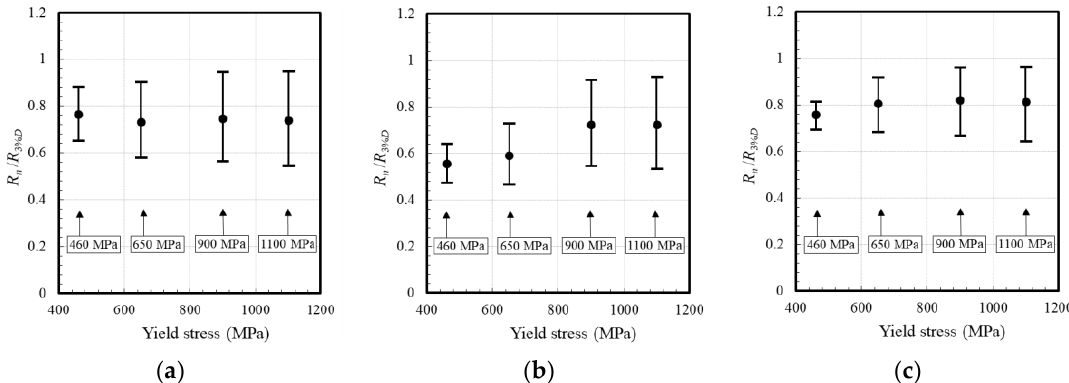
Figure 15. Comparison of design equations using reduction factors ( β ) with analysis results: ( a ) AISC (2016); ( b ) Eurocode (2005); ( c ) ISO 14346. Table 13. Reduction factors for high-strength steel.